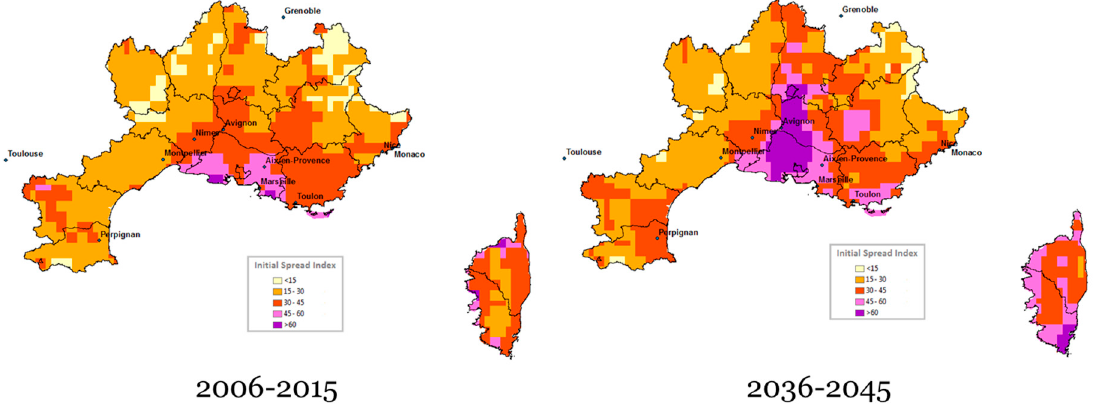
Figure 13. Average annual Initial Spreading Index for present and future RCP8.5.